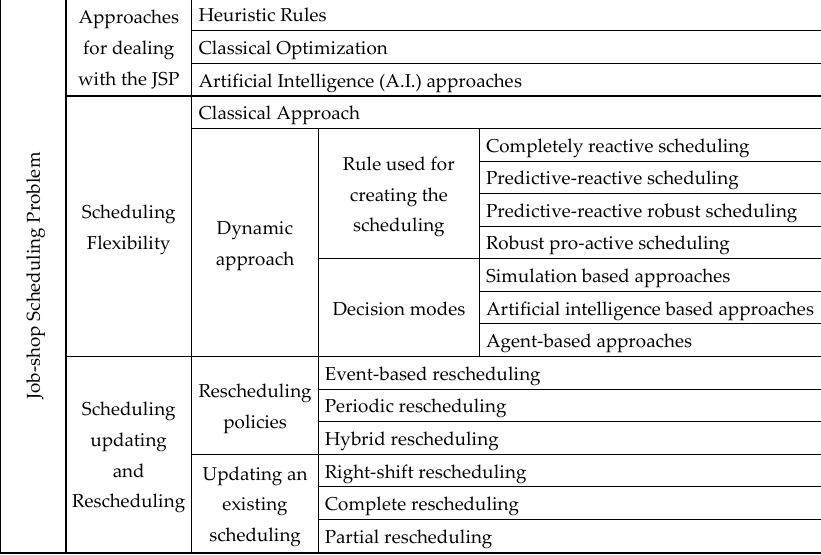
Figure 2. Job-shop Scheduling Problem approaches and methods.